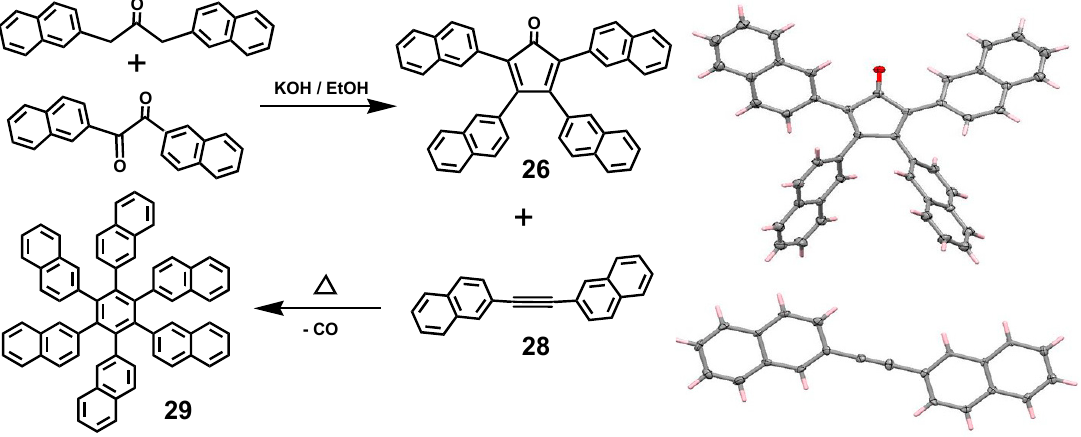
Figure 13. ( left ) synthetic route to hexa( β -naphthyl)benzene, and ( right ) molecular structures of tetra( β -naphthyl)cyclopentadienone, 26 , and di( β -naphthyl)acetylene, 28 .